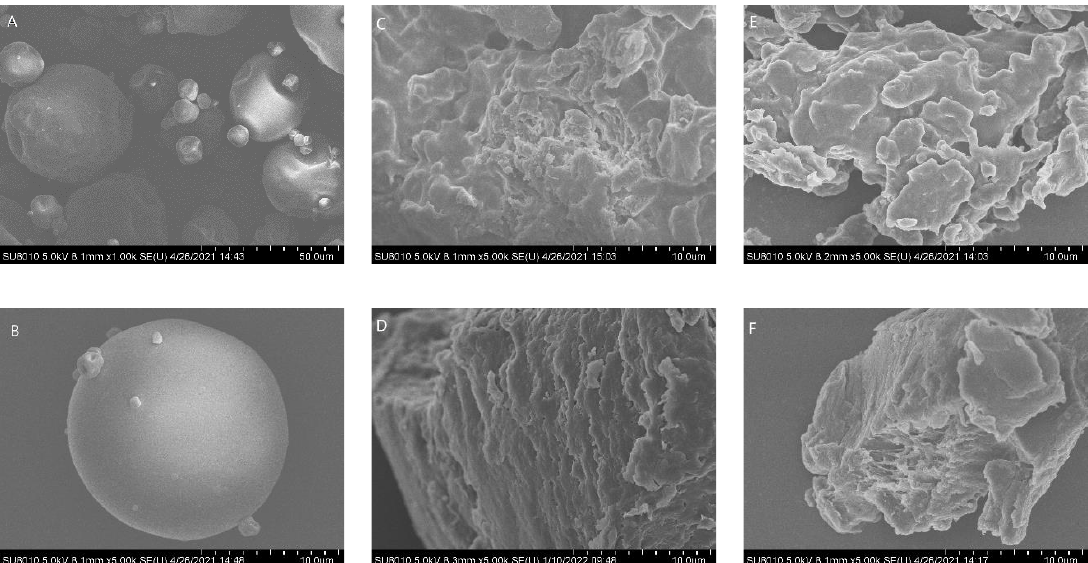
Figure 3. SEM micrographs of the textured rice protein at different extrusion parameters ( A ) Rice protein at 1 K magnification; ( B ) Rice protein at 5 K magnification; ( C ) TRP at 5 K magnification at 200 rpm, 90 °C, and 30%; ( D ) TRP at 5 K magnification at 200 rpm, 130 °C, and 30%; ( E ) TRP at 5 K magnification at 100 rpm, 130 °C, and 30%; ( F ) TRP at 5 K magnification at 200 rpm, 130 °C, and 40%. In contrast, TRPI at 200 rpm, 130 ◦ C, and 40% was observed under 5 K The shape of the TRP at 200 rpm, 90 °C, and 30% was in between other TRPs. Under